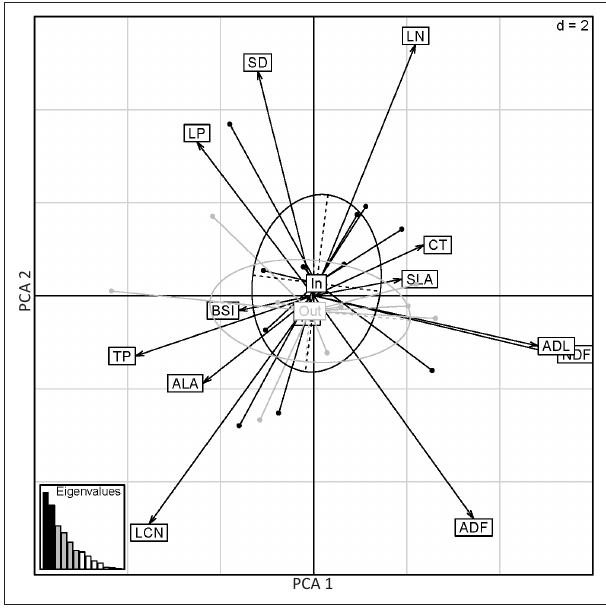
FIGURE 8: Principal components analysis of trait measurements from 20 species sampled inside and outside of three exclosures in the Kruger National